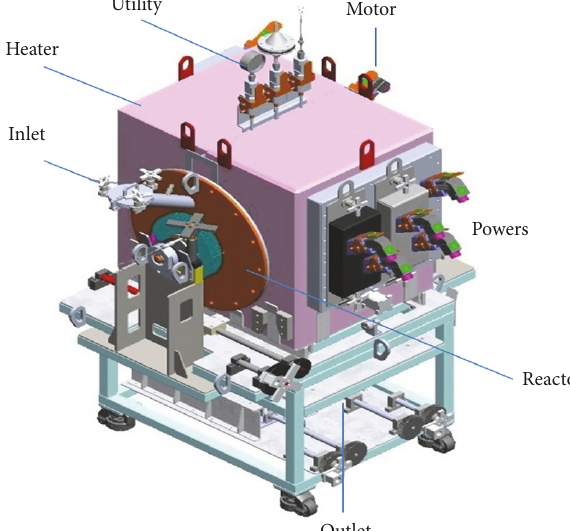
Figure 15: A 3D model of the